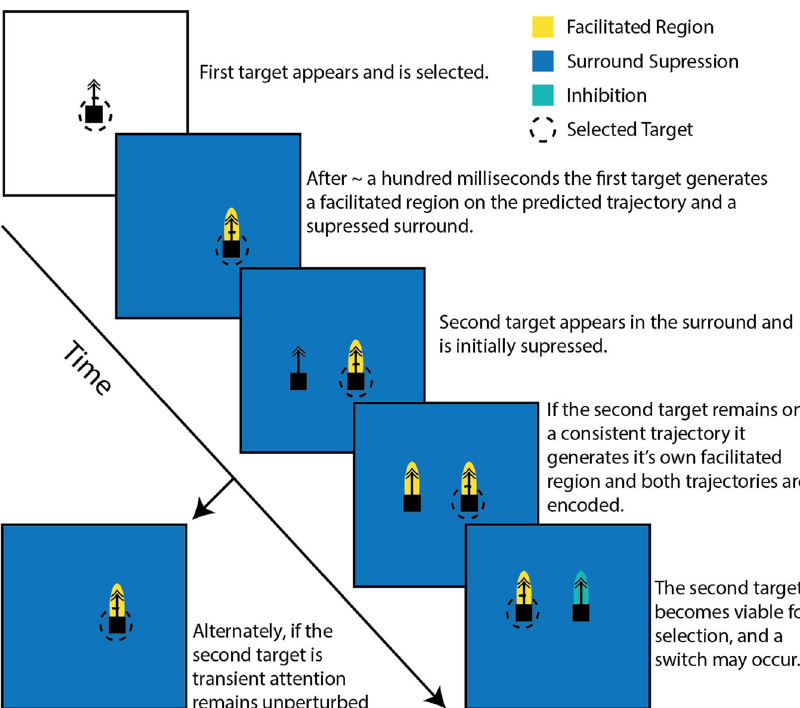
Fig. 6 Schematic depicting the proposed interaction between Predictive Gain Modulation and target selection. Predictive Gain Modulation may act as a gatekeeping mechanism for selection by suppressing transient stimuli that appear elsewhere within the excitatory receptive fi eld, but passing consistent stimuli that may be of potential behavioural relevance. This ensures the attention system does not get captured by transiently highly-salient distractions, but is still afforded the fl exibility to track and respond to novel